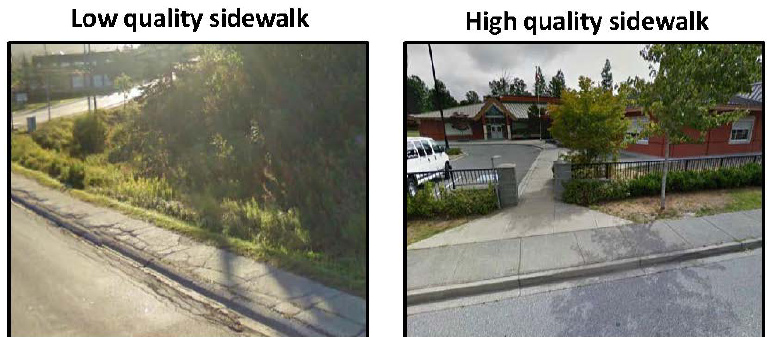
Figure 3. Google Street View images of sidewalk